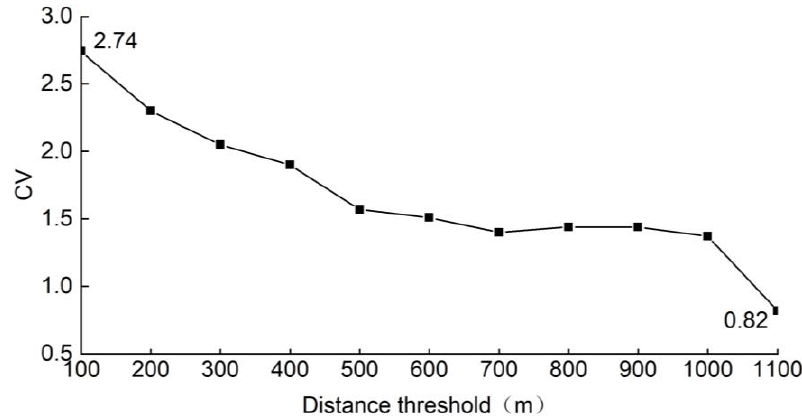
Figure 5. Coefficient of variation of dI values under different distance thresholds. Our green patch nodes selected by the connectivity index can match the popular parks in Kashgar City. The determined green patch nodes are mainly distributed in the study area's east, middle, and west (Figure 6a). In the northern part of the study area, green space patches are usually small and spread out, with no critical green space patch nodes. The chosen green patch nodes have a high connectivity index and a high recrea- tional value. East Lake Park, People's Park, and Xiaoyalang Wetland Park are in the top